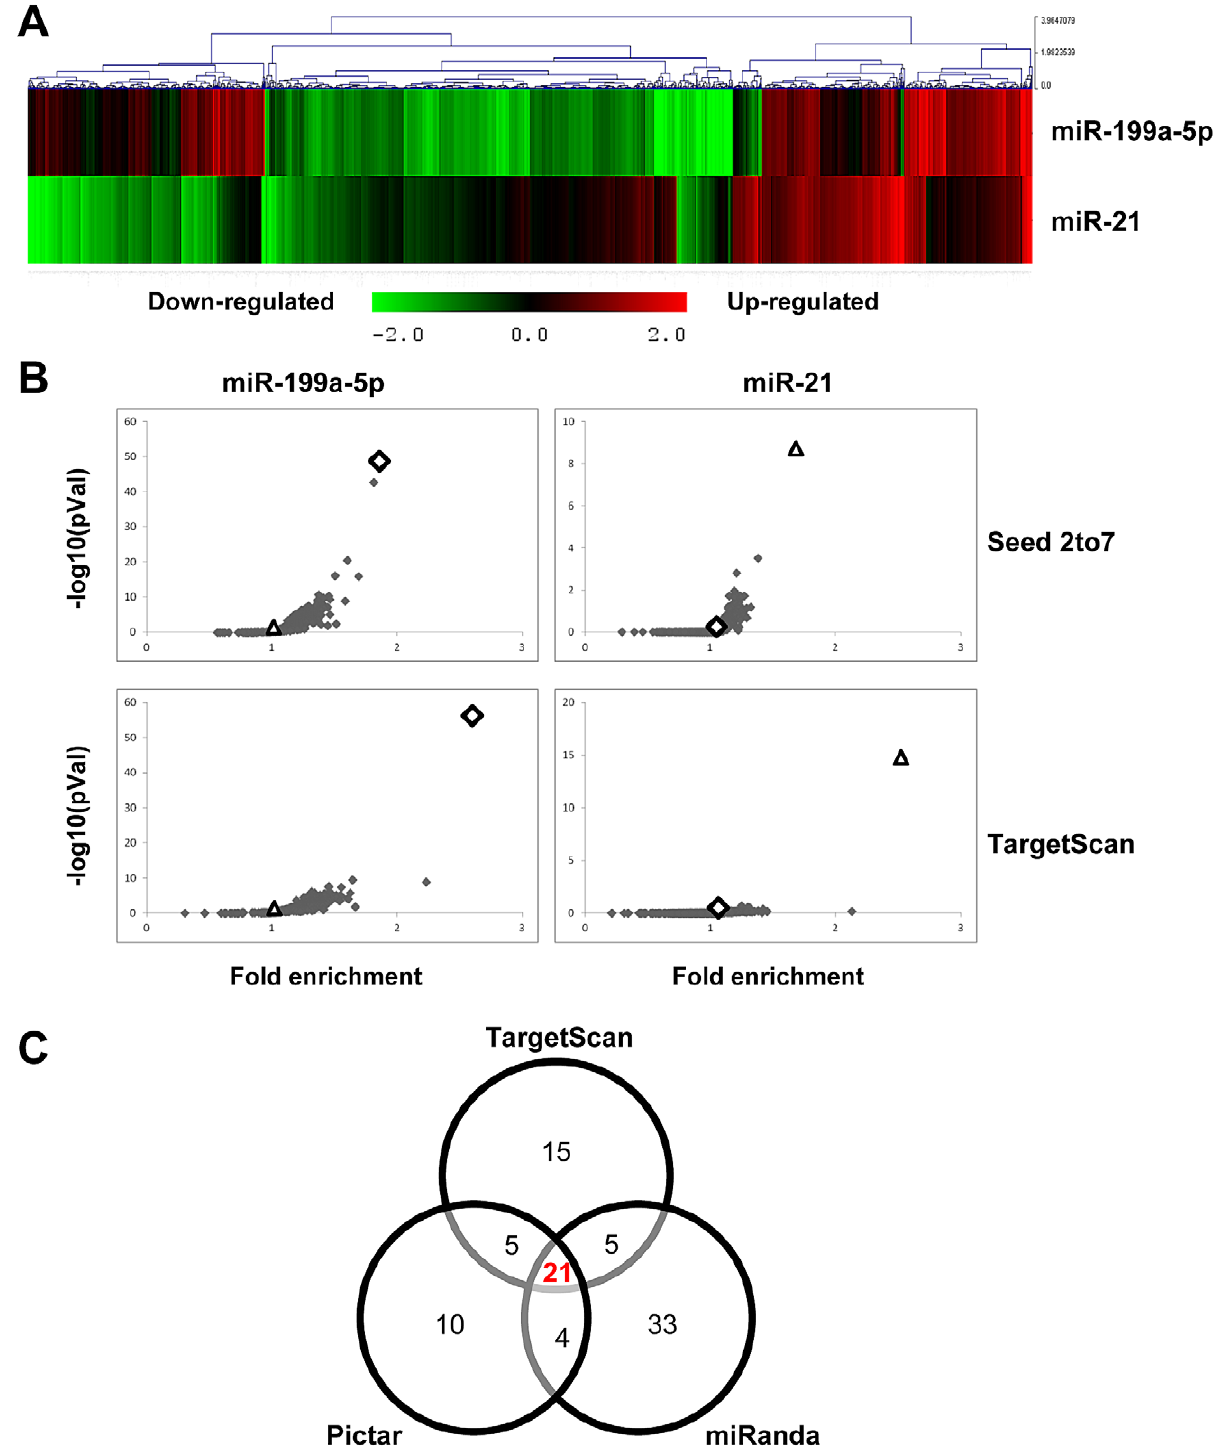
Figure 2. Identification of miR-199a-5p candidate targets using a transcriptomic approach. Normal human pulmonary fibroblasts hFL1 were transfected with pre-miR-Neg, pre-miR-199a-5p or pre-miR-21 (n=2). RNA samples were harvested at 48 h post-transfection and expression profiles were determined with pan genomic arrays. (A) Heatmap comparing the normalized log 2 of the ratios between the signal in the different conditions and the pre-miR-Neg signal. (B) Overrepresentation of miRNA predicted targets in the set of down-regulated transcripts following miR- 199a-5p and miR-21 transfection using the webtool miRonTop. Graphs show the significance of the enrichment, represented as 2 log 10 (adjusted p- value), according to the fold enrichment using 2 different prediction tools for all known miRNAs: miR-199a-5p and miR-21 are represented as an open diamond and triangle, respectively. Threshold values used to define the set of up- and down-regulated genes: AveExp=7.0; log FC=0.7; adjusted p- value=0.05. (C) Venn diagram comparing the number of miR-199a-5p targets among the set of highly-downregulated genes following pre-miR-199a-